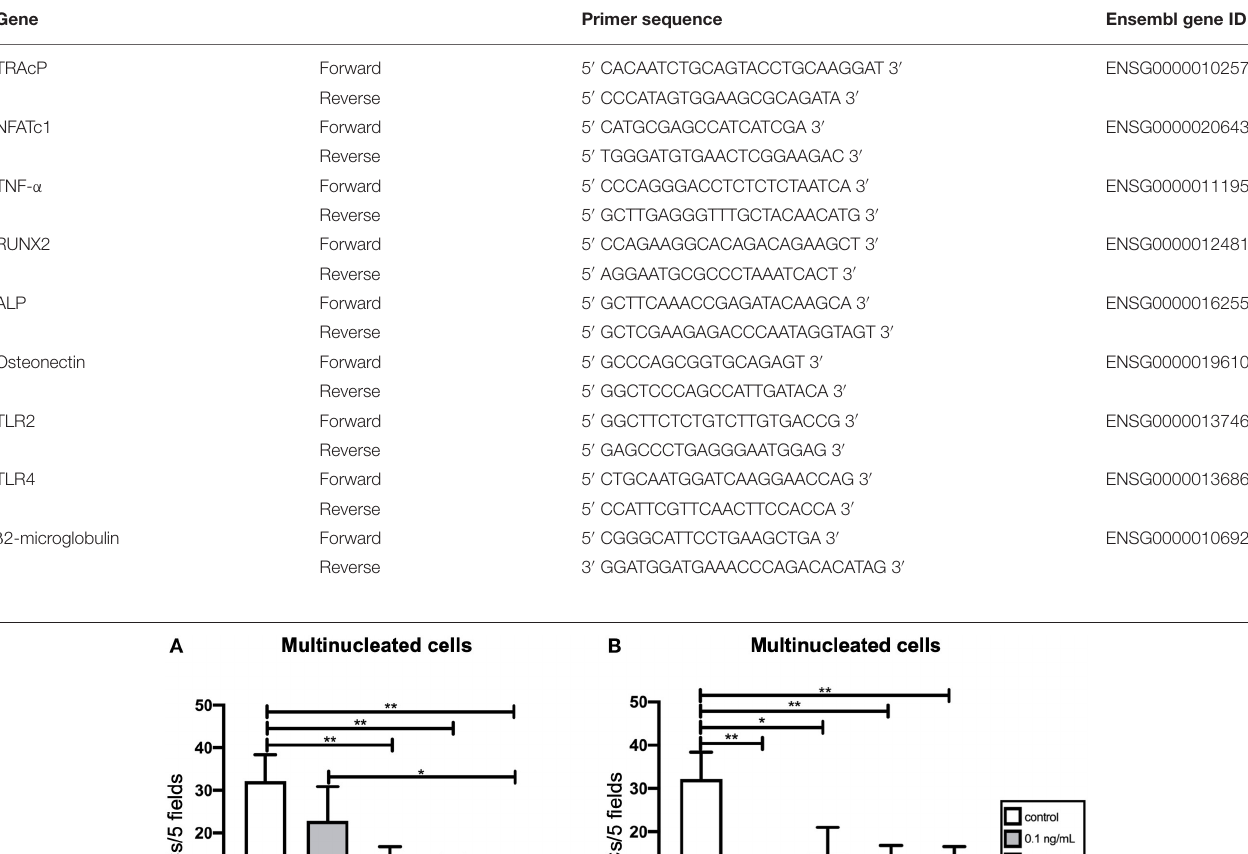
TABLE 1 | Primer sequences used for RT-qPCR experiments.